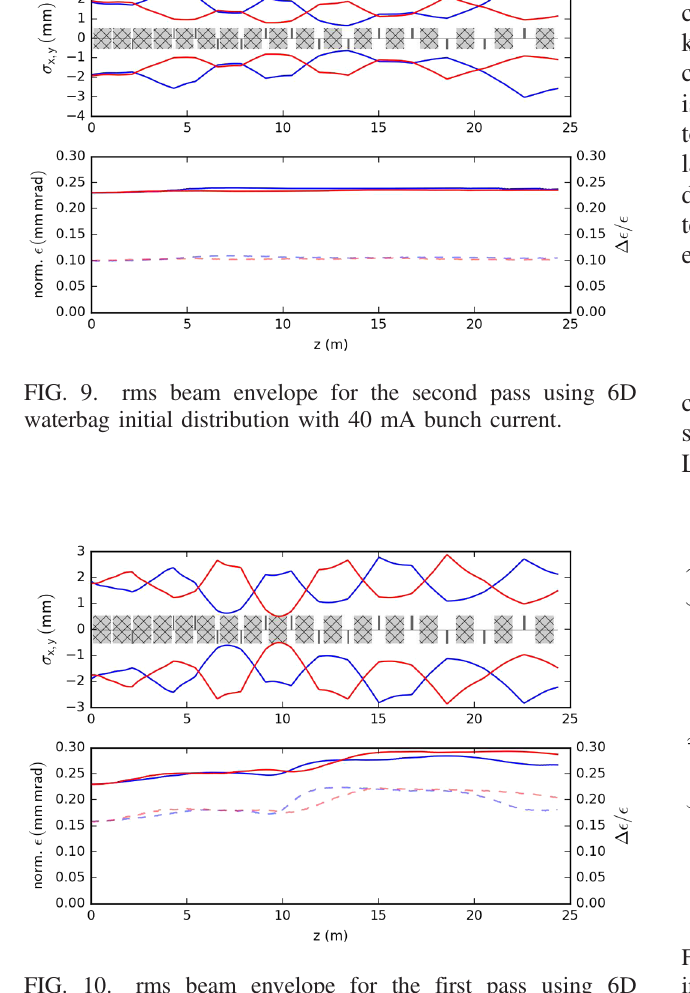
FIG. 10. rms beam envelope for the first pass using 6D Gaussian initial distribution with 40 mA bunch current.